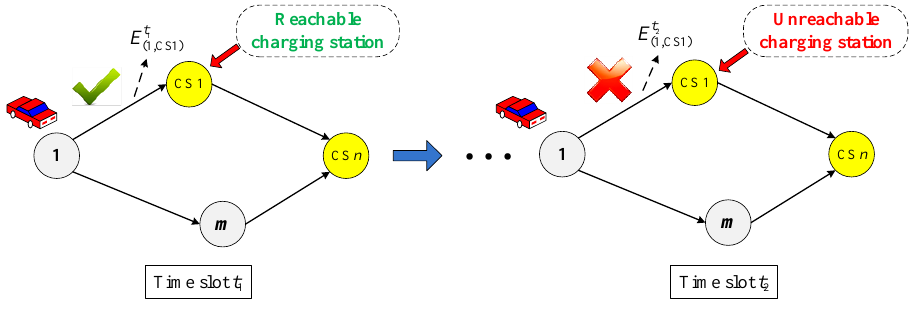
Figure 1. Reachable and unreachable charging stations (CS).